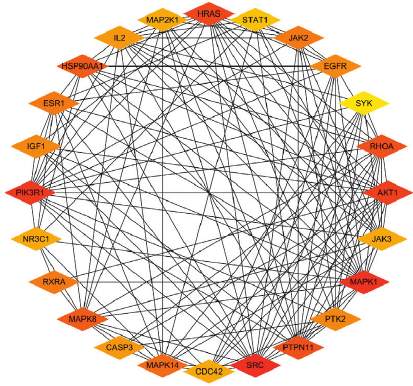
Figure 11: Interaction network of 24 core